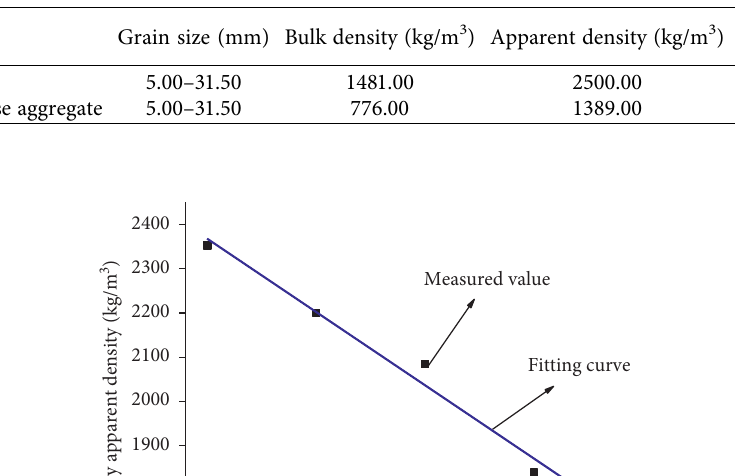
Table 1: The basic physical property of coarse aggregate.